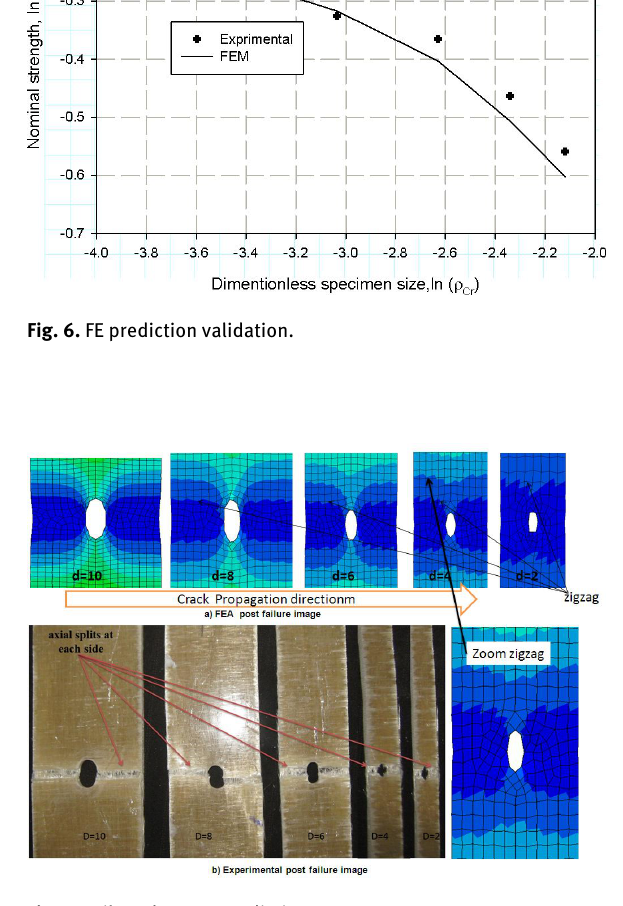
Fig. 7. Failure damage